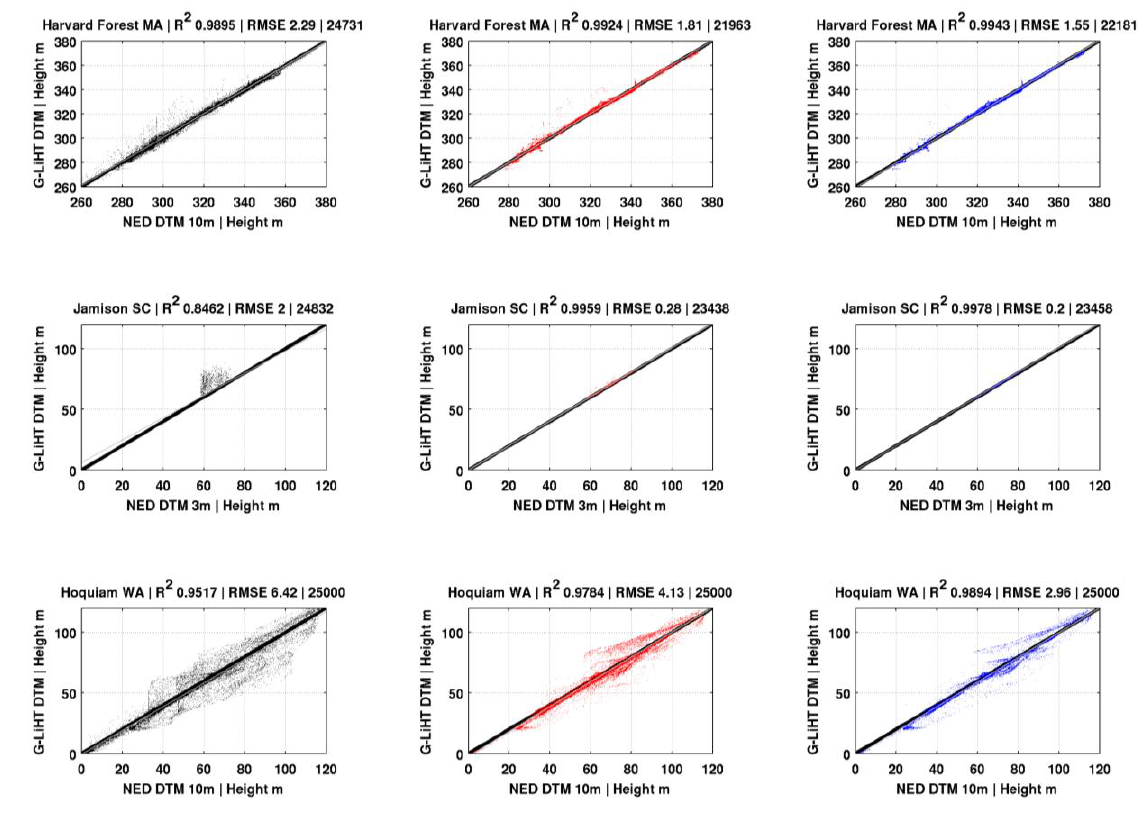
Figure 3. Scatter plots of three regions using a standard normal distribution of 25,000 randomly sampled points after filtering from Table 2 comparing NED DTM vs. G-LiHT DTM. The black line indicates a one-to-one relationship and the thin gray line indicates a least squares linear fit. The total number of samples is displayed in the plot title. Black points indicate no filtering, red points indicate data filtered with high LiDAR reflectance and blue points indicate data filtered with high LiDAR reflectance and slopes less than